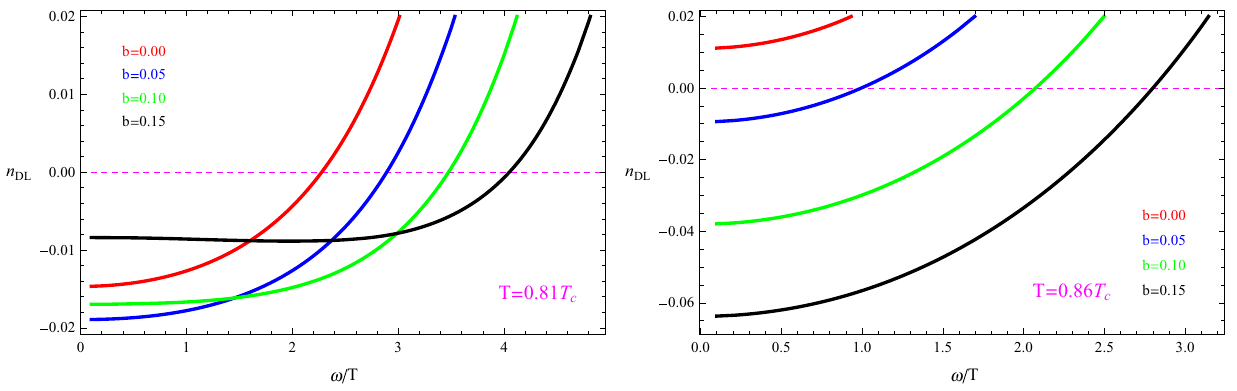
Fig. 4 The Depine–Lakhtakia index n DL as a function of ω/ T with the fixed temperatures T = 0 . 81 T c (left) and T = 0 . 86 T c (right) for different values of the Born–Infeld parameter b . The four lines in each